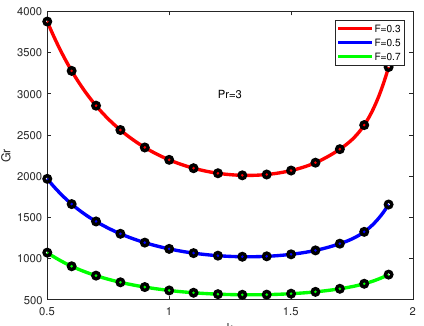
Figure 11. Marginal stability curves for Pr = 3 (Case 2).